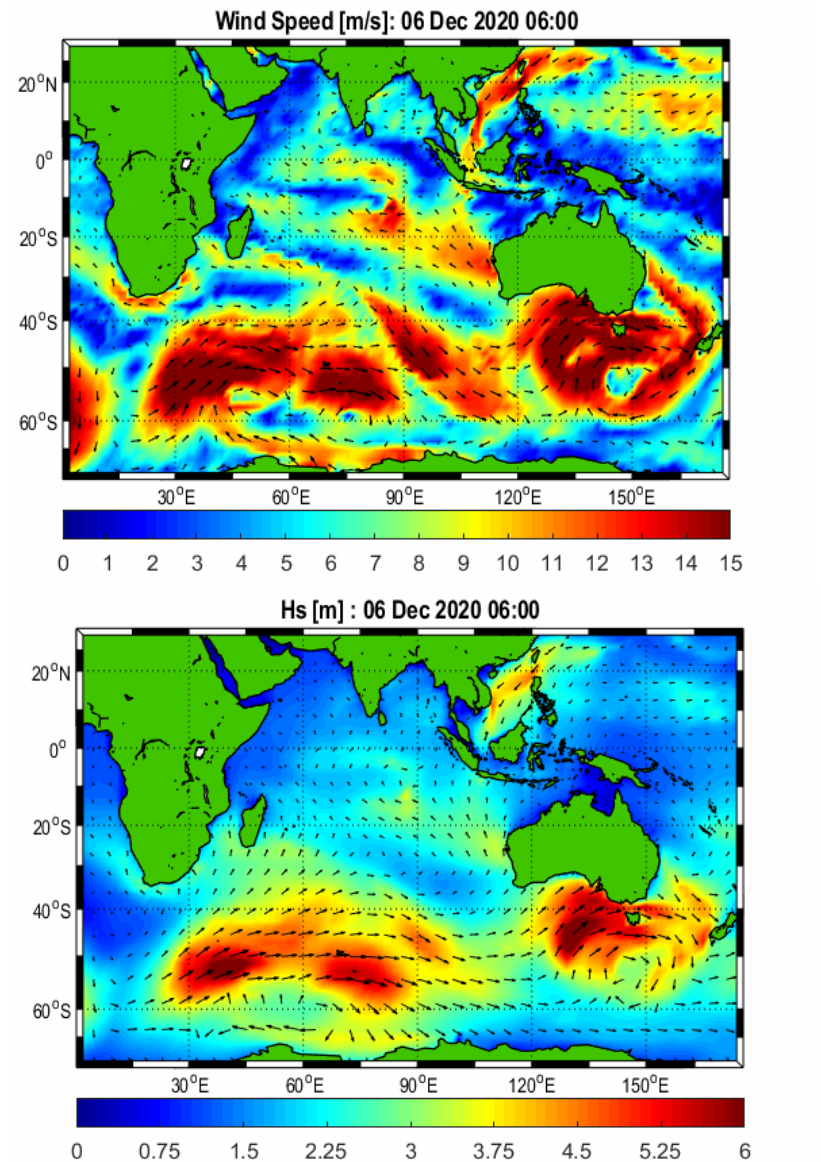
Figure 4. Snapshot of the wind field (upper plot) and the resulting significant wave height from the SWAN simulation (lower plot) in